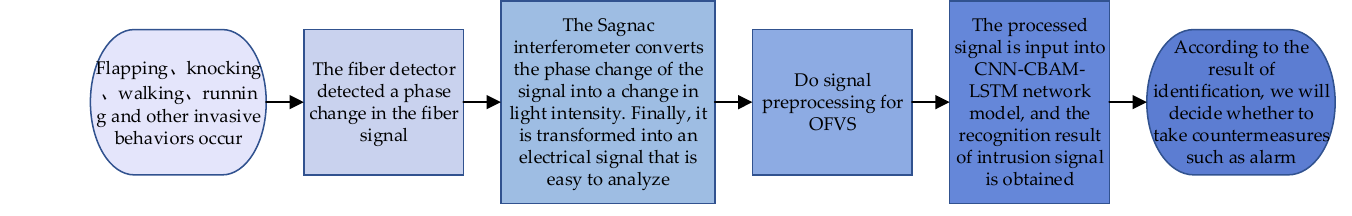
Figure 4. Overall research flow chart.